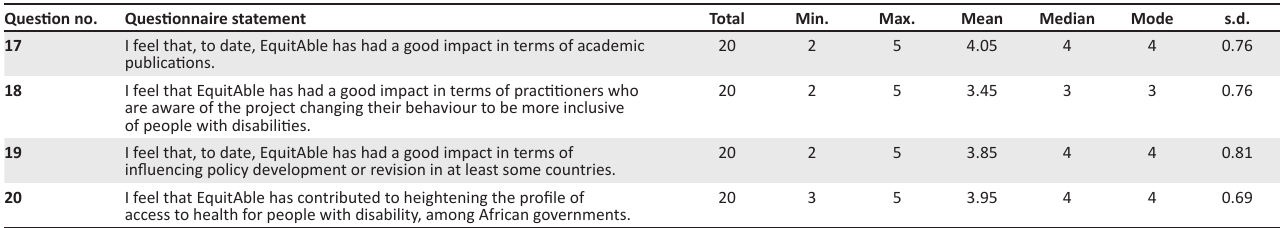
TABLE 4: EquitAble impact. Question